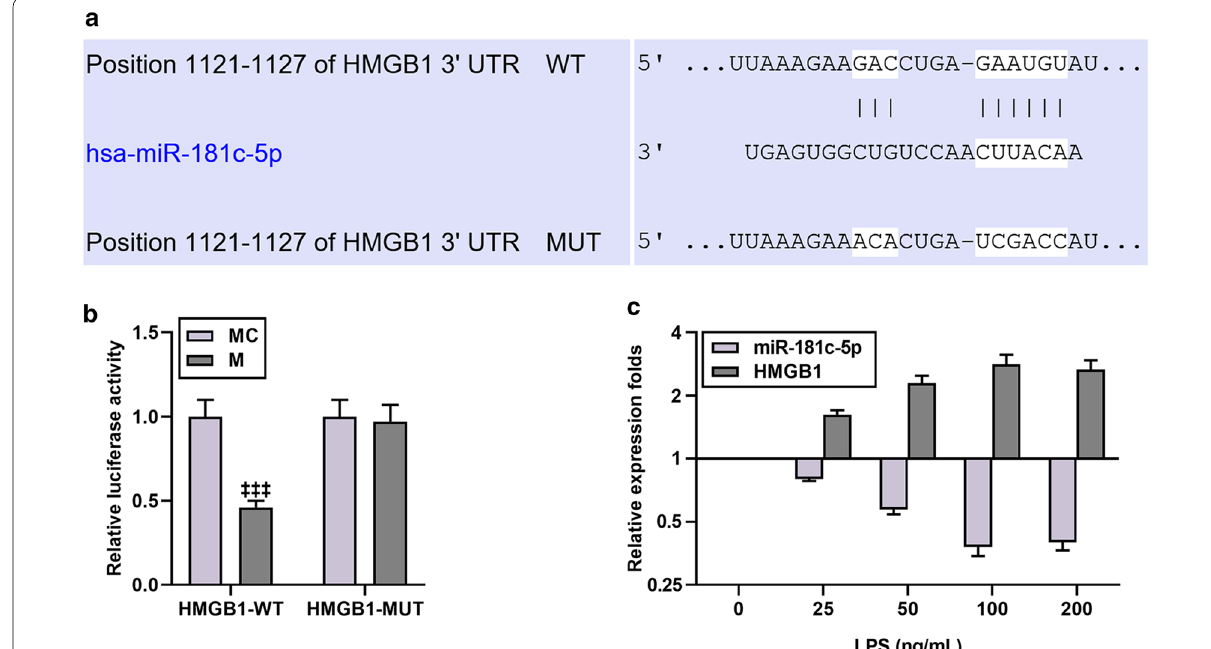
Fig. 3 MiR-181c-5p bound to HMGB1 and may have a negative correlation with HMGB1 in LPS-induced microglia. a TargetScan v7.2 (http:// www. targe tscan. org/ vert_ 72/) and b dual luciferase assay were used to predict and verify the binding relationship between miR-181c-5p and HMGB1, respectively. HMGB1-WT was the group with wild-type sequence of HMGB1 inserted into a luciferase reporter plasmid. HMGB1-MUT was the group with mutant sequence of HMGB1 inserted into a luciferase reporter plasmid. N 3 for each column; ‡‡‡ P < 0.001 t test vs MC. c After induction with = different concentrations of LPS (25, 50, 100, 200 ng/mL), qRT-PCR was used to detect the expressions of miR-181c-5p and HMGB1 in microglia. β-actin or U6 was used as a control. M miR-181c-5p mimic, MC miR-181c-5p mimic control, ELISA enzyme linked immunosorbent assay,